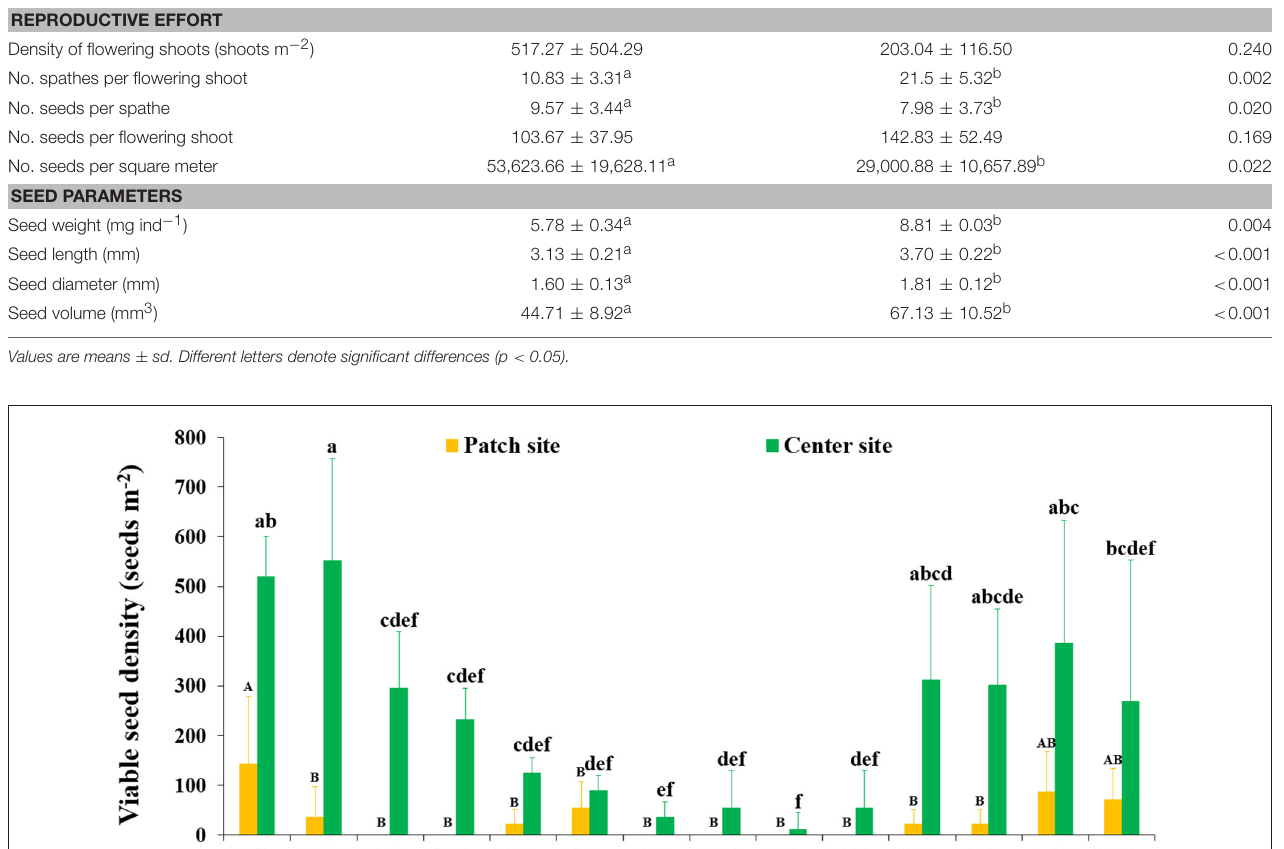
with substantial variances at both the patch and center sites ( F = 2.762/3.014, df = 54/59, P = 0.007/0.003,